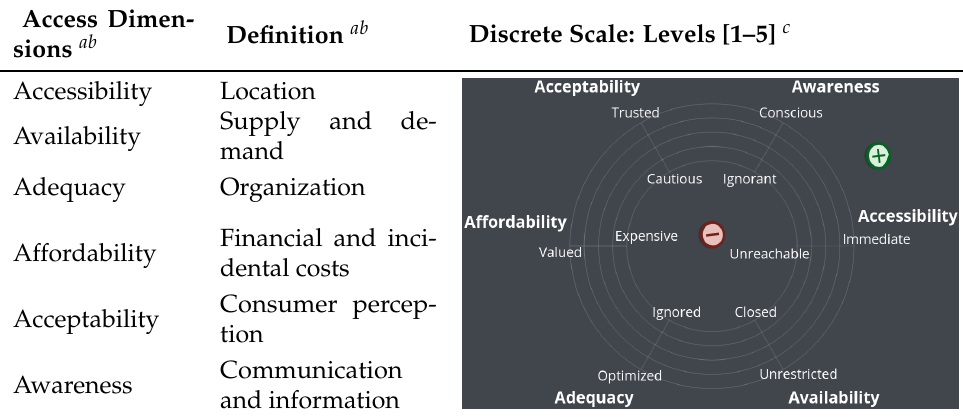
Table 1. Scaled access dimensions present in the